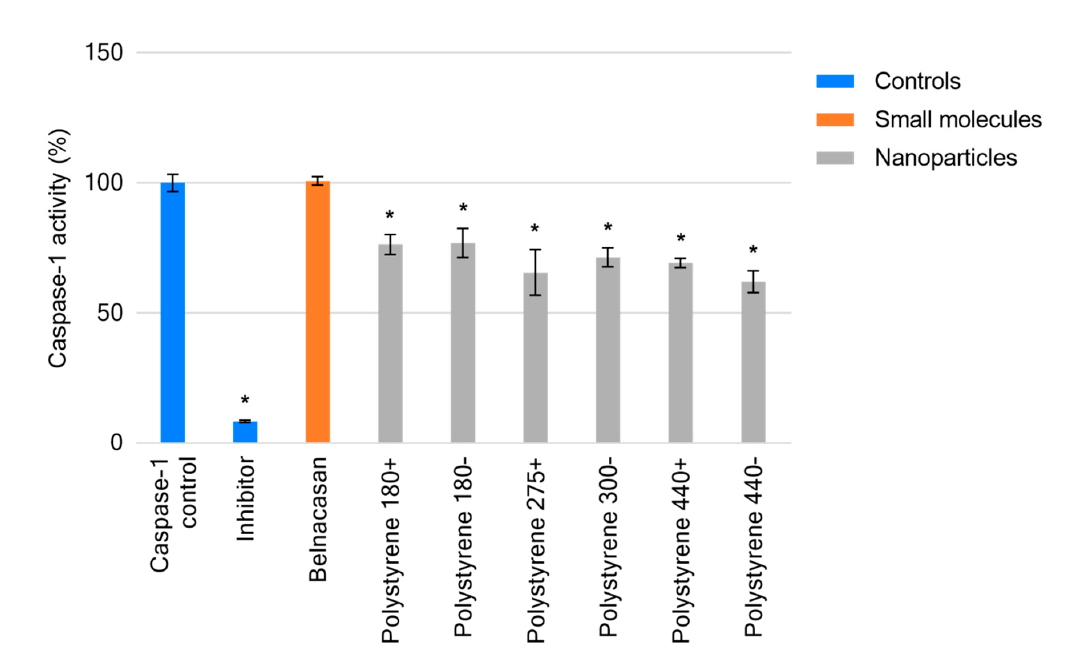
Figure 3. Caspase-1 activity displayed as a percentage of total activity in the caspase-1 control, following treatments with small molecules and stated nanomaterials. Data displayed as an average of three technical replicates ± standard deviation. * p -value <